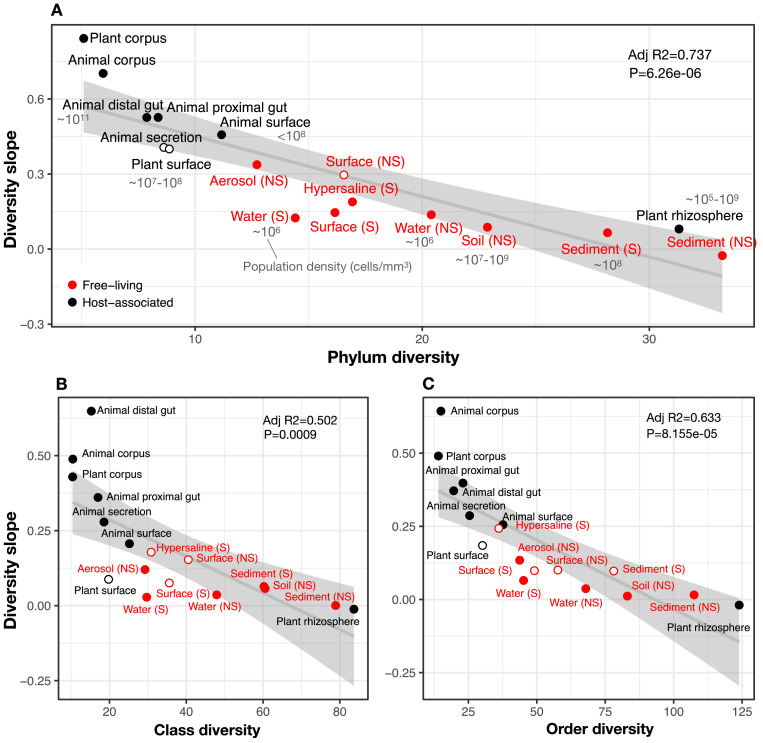
The diversity slope of focal taxa is higher in low-diversity (often host-associated) microbiomes.The x-axis shows the mean number of non-focal taxa: (A) phyla, (B) classes, and (C) orders in each biome. On the y-axis, the diversity slope was estimated by a GLMM predicting focal lineage diversity as a function of the interaction between community diversity and environment type at the level of (A) Class:Phylum, (B) Order:Class, and (C) Family:Order ratios (Supplementary file 1 Section 3). The line represents a linear regression; the shaded area depicts 95% confidence limits of the fitted values. Adjusted R2 and P-values from the linear fits are shown at the top right of each panel. See Supplementary file 2 for model goodness of fit. Slopes not significantly different from zero are shown as empty circles. Estimates of bacterial cell density from the literature are indicated in grey text, in units of bacteria/mm3. For animal (skin) and plant surface, units of bacteria/mm2 were converted to mm3 assuming layers of bacteria one micron thick. For rhizosphere samples we assume a density of 1–2 g/cm3 (Kennedy and de Luna, 2005).